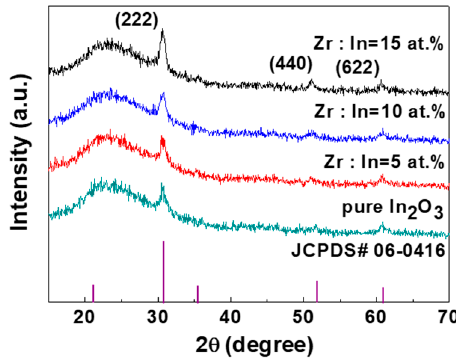
Figure 4. X-ray di ff raction (XRD) patterns of the In x Zr y O films with di ff erent Zr contents (Zr:In = 0, 5, Figure 4. X-ray diffraction (XRD) patterns of the In x Zr y O films with different Zr contents (Zr:In = 0, 5, 10, and 15 at.%) annealed at 400 ◦ C. 10, and 15 at.%) annealed at 400 °C.